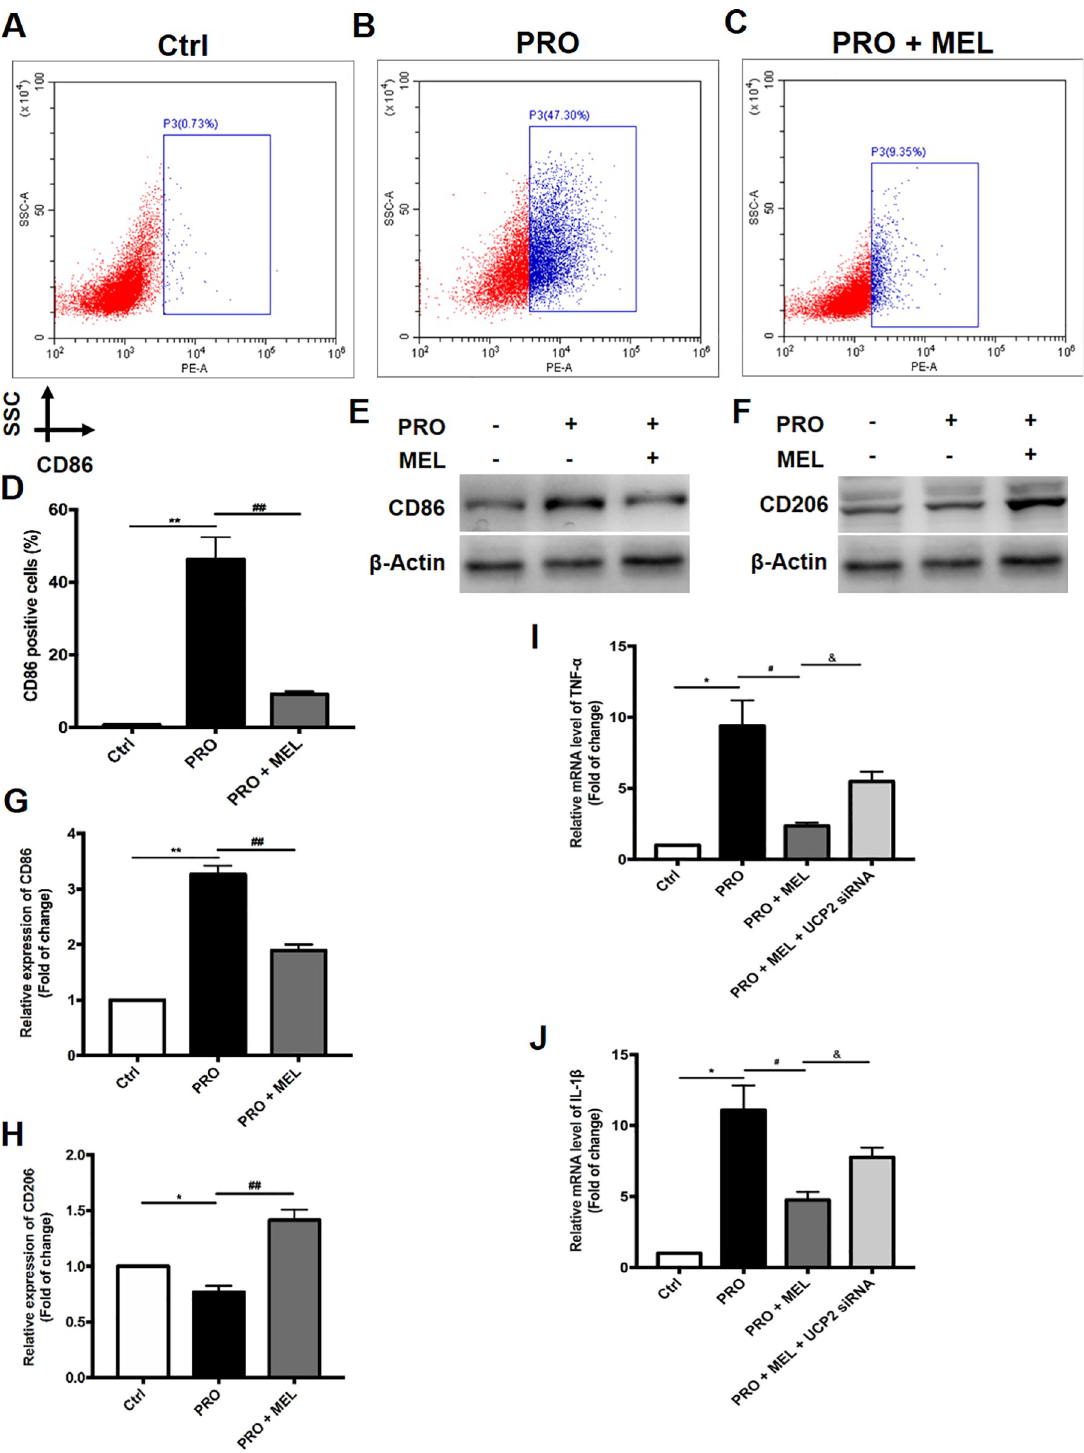
Fig 1. Prorenin increases M1 phenotype (CD86-positive) switching in primary microglial cells. Cells were treated with control medium or prorenin (20 nmol/L) for 24 hr, followed by analysis of M1 phenotype (CD86-positive) cells by using flow cytometry. (A–D) SSC: side scatter. Western blot analysis and representative bands of CD206 and CD86 expression were shown. Membranes were re- probed for β -actin expression to show that similar amounts of protein were loaded in each lane. (E-H) IL-1 β and TNF- α mRNA levels were quantified by real time PCR. Primary microglia were treated with control solution (DMEM) or prorenin (20 nmol/L) in the